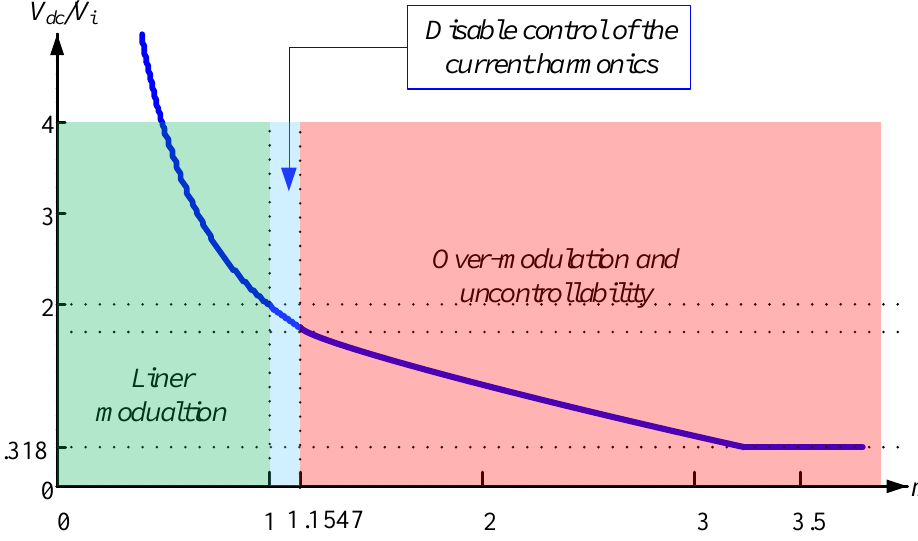
Figure 5. 2L-VSC gain ( V dc /V i ) vs. modulation index ( m ) in the rectification mode.